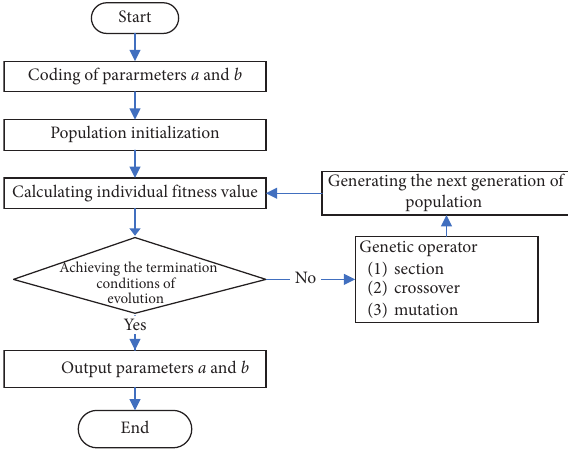
Figure 5: The flowchart of parameter optimization in VMD by using